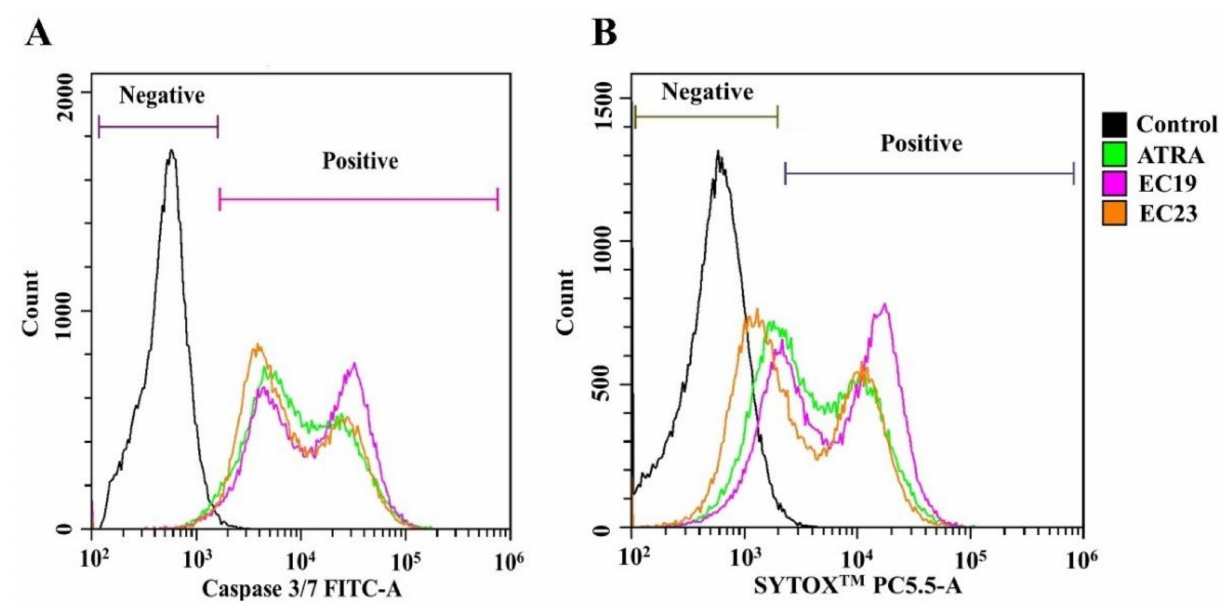
Figure 1. Overlay histogram of Caco-2 cell population detected with Caspase-3/7 Green and SYTOX™ Flow Cytometry Assay Kit after exposure to retinoids. The cells were manipulated with the IC 50 dose of ATRA or EC-synthetic retinoids for 24 h. Negative control is cells treated with 0.1%DMSO. Both ( A ) the CellEvent™ Caspase-3/7 Green Detection Reagent and ( B ) the SYTOX™ AADvanced™ Dead Cell Stain were used to detect apoptotic and necrotic populations, respectively. The samples were analyzed by Cytoflex flow cytometer using 530/30 and 690/50 bandpass filters, respectively. Retinoids induced more staining with both dyes causing population shift in comparison to the untreated control, reflecting the activation of both apoptosis and necrosis. Shown are representative histograms of three independent experiments ( n =